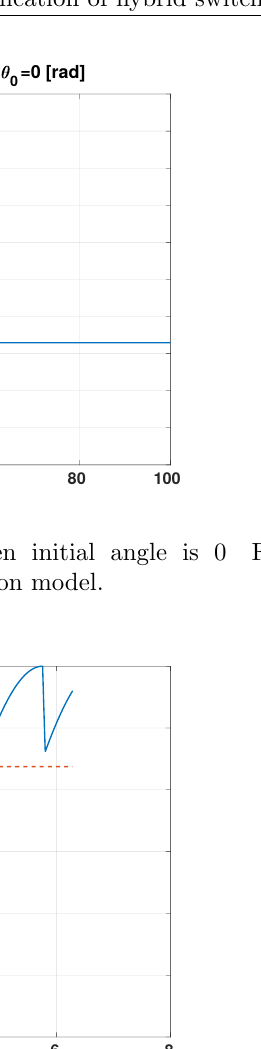
Figure 4: Equilibrium points when initial angle is π [rad].